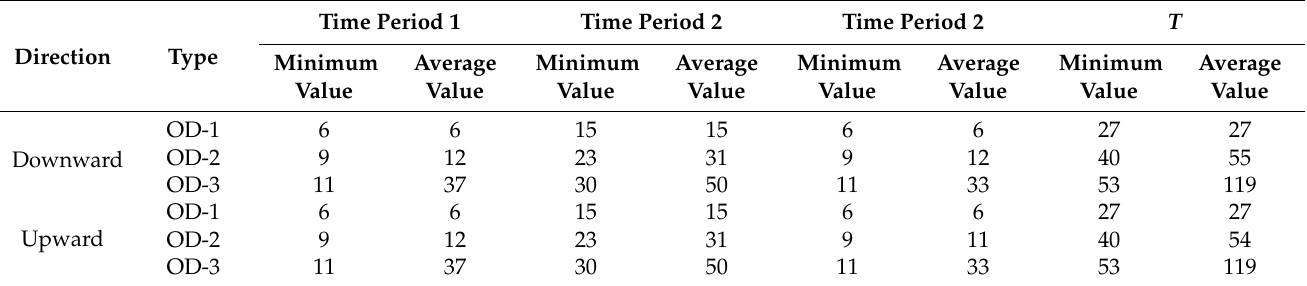
Table 9. OD service frequency.